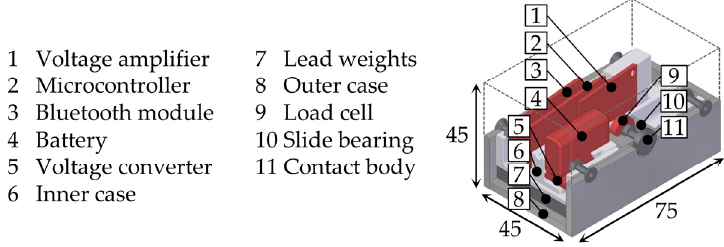
Figure 3. Force measurement device.